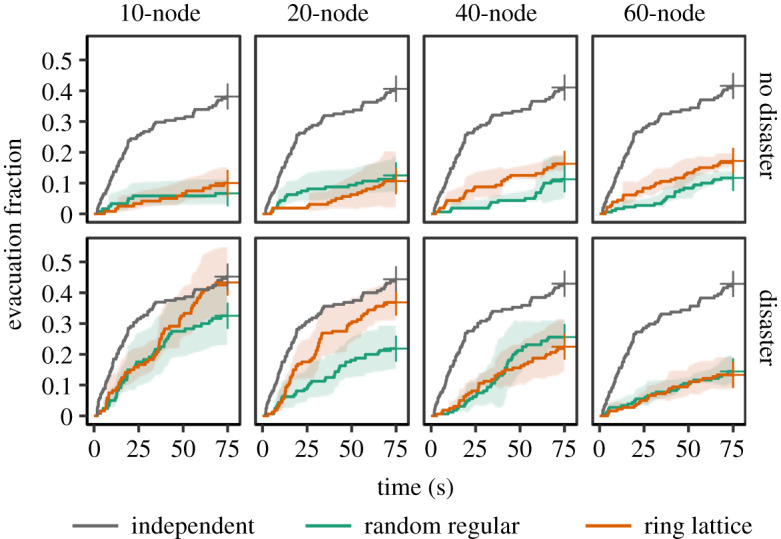
Aggregated evacuation fraction over time. Lines indicate average fractions of evacuated subjects over time in different experimental conditions. Shades are 95% confidence intervals among network sessions (N = 12 for 10-node; N = 8 for 20-node; N = 4 for 40-node; N = 3 for 60-node networks). The lines of the ‘independent’ condition (of solitary nodes) are identical with the exception of the single informed subject (who differed in the disaster and no-disaster situations). When a ‘disaster’ does not strike, subjects embedded in networks are more likely to select an appropriate action (i.e. to stay) than those subjects in the isolated condition. However, when a ‘disaster’ does strike, subjects embedded in networks are less likely to select an appropriate action (i.e. to evacuate) and more likely to suffer the consequences of the disaster than those in the independent condition. Random regular in green; ring lattice in orange. (Online version in colour.)